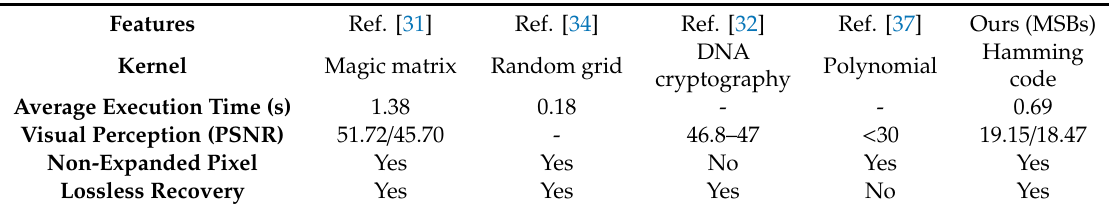
Table 5. Comparison of various features for di ff erent